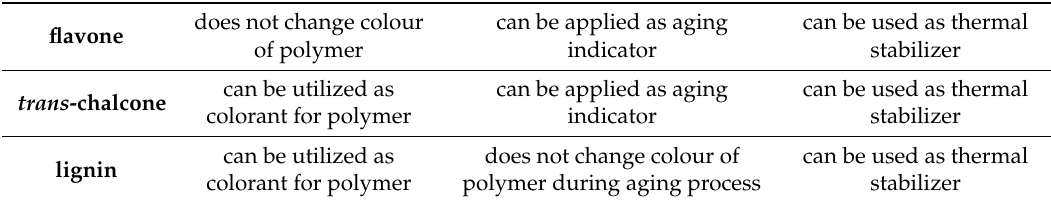
can be applied as aging indicator does not change colour of polymer during aging process